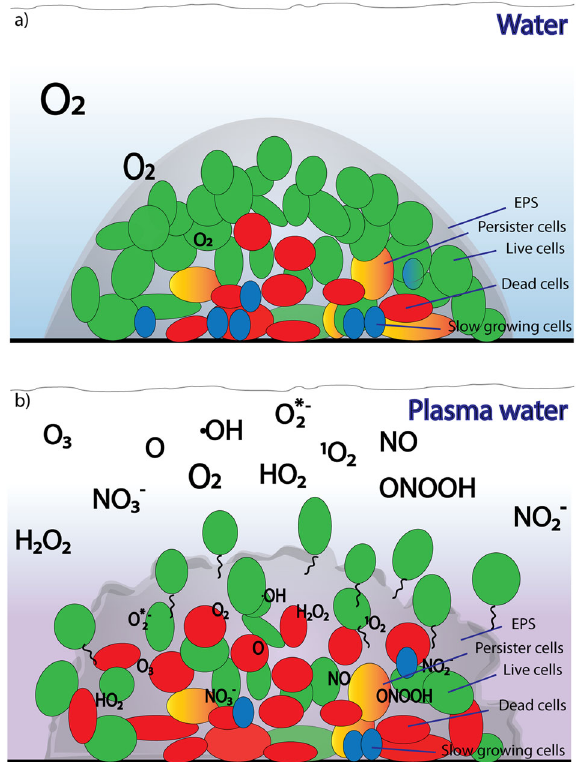
Fig. 7 Proposed mechanism of interaction of PAW with bio fi lms relying on active species to disrupt the matrix leading to effective bio fi lm dispersal. Under non-plasma conditions an oxygen gradient will form in a microcolony ( a ). Interaction of PAW with microbial bio fi lms will generate a range of active RONS that can penetrate into the interior of microcolonies and kill bio fi lm cells. RONS will also lead to the disruption of the bio fi lm matrix and thus releasing cells from the bio fi lm interior ( b